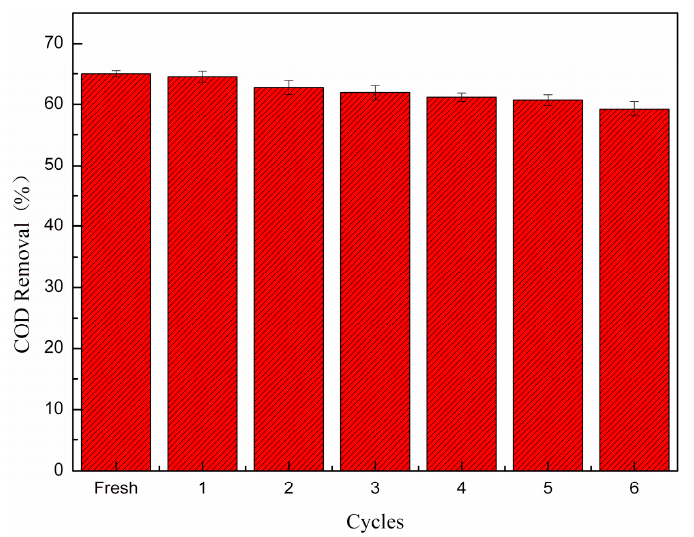
Figure 11. Effect of recycling the catalyst on COD removal (initial pH of 2.0; Catalyst dosage of 10.0 g/L; The concentration of H 2 O 2 is 0.5 mol/L; The illumination distance is 20 cm).